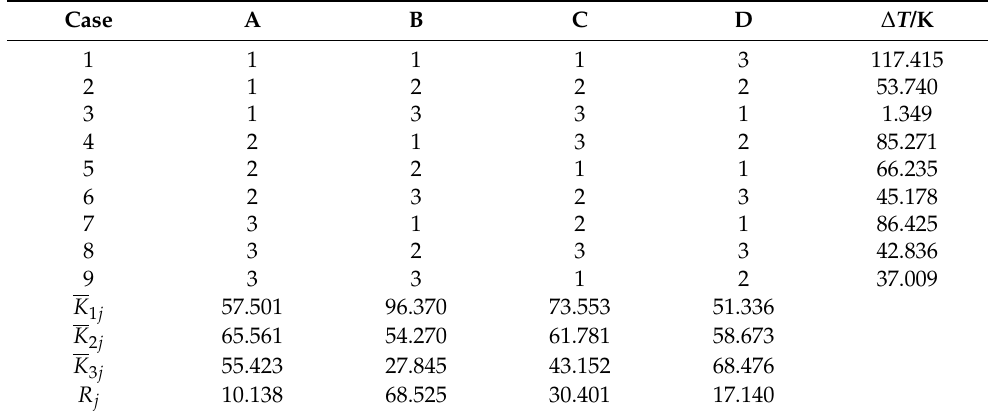
Table 7. Orthogonal test range analysis.